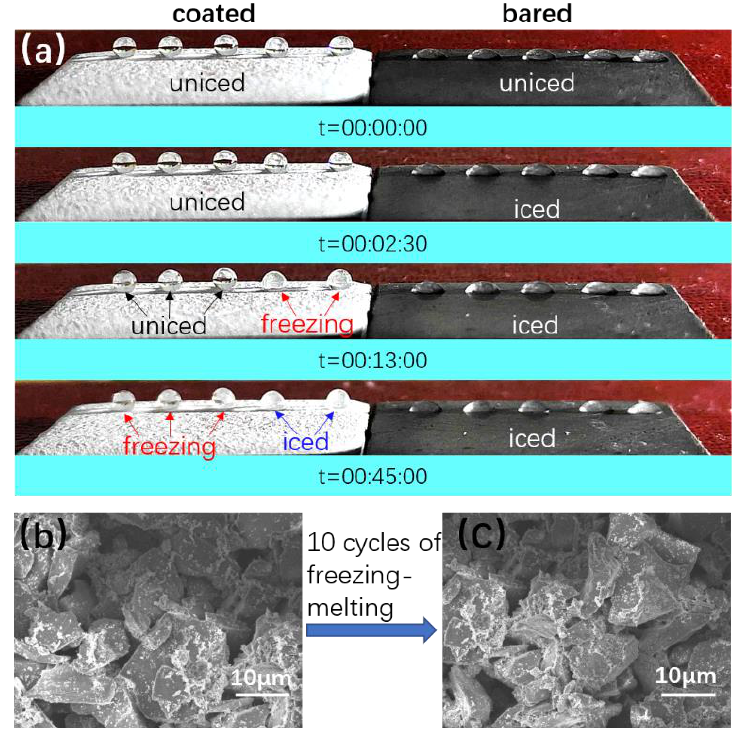
Figure 22. ( a ) The freezing process of a water droplet on superhydrophobic coating and Q235 steel. ( b,c ) SEM photographs of the coating after 10 freezing/melting cycles.